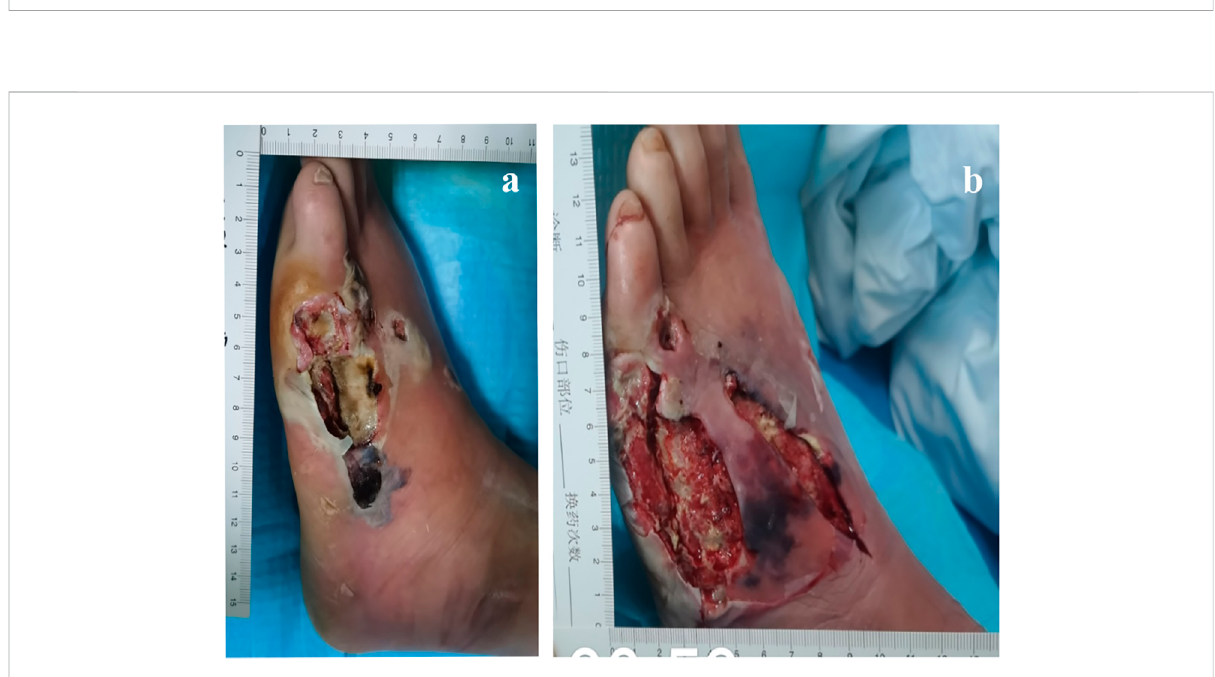
FIGURE 3 57-year-old man with diabetes mellitus had a non-healing ulcer in the front of his left foot. (A) After admission. (B) After debridement.